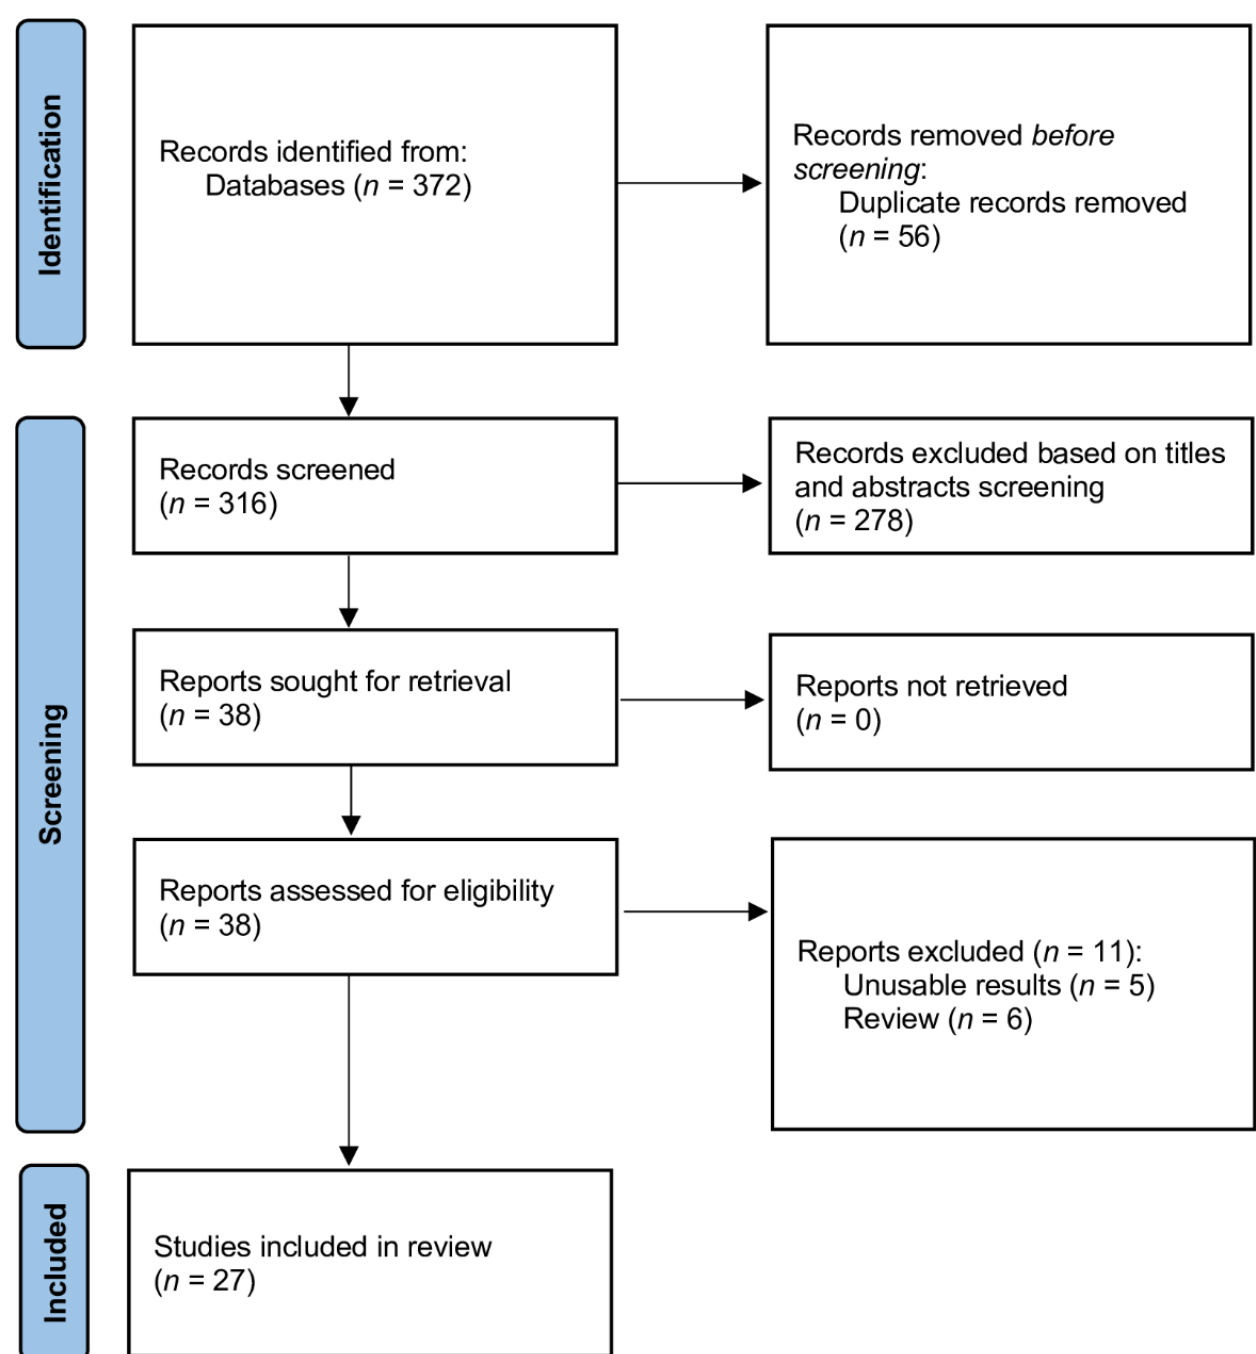
Figure 1. Flow diagram showing stages of the database search and study selection as per Preferred Reporting Items for Systematic Reviews and Meta-Analyses (PRISMA) guidelines. Among the included trials, the mean age of patients with and without ACS varied and Table 1. Characteristics of included studies. Legend: NR = not reported. amounted to 66.1 ± 10.4 versus 62.2 ± 12.7 years, respectively. Males accounted for 71.5% of patients in the ACS group compared with 59.3% in the patients without ACS group. The details of the included studies are summarized in Table 1 and Table